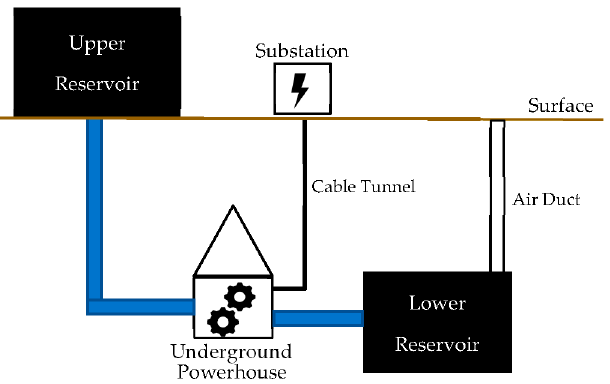
Figure 2. Diagram of UPHS, where the lower water reservoir is an underground cavern or mine. Adapted from [22].